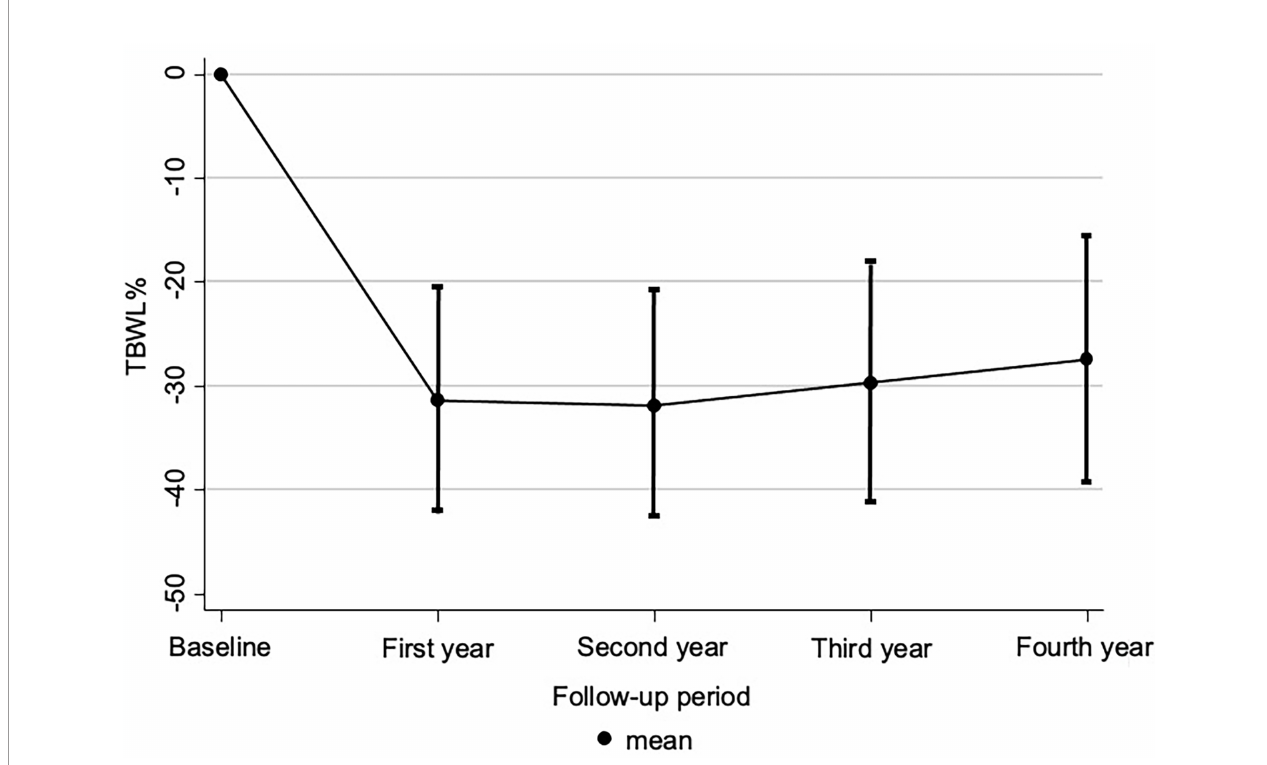
FIGURE 2 | Weight plot over time. Values are show as the mean values of total body weight loss, TBWL%, (represented by the dots), and its standard deviation (vertical lines). TBWL%: − (weight at baseline evaluation − weight at fi rst/second/third/fourth year evaluation)/weight at baseline evaluation × 100.